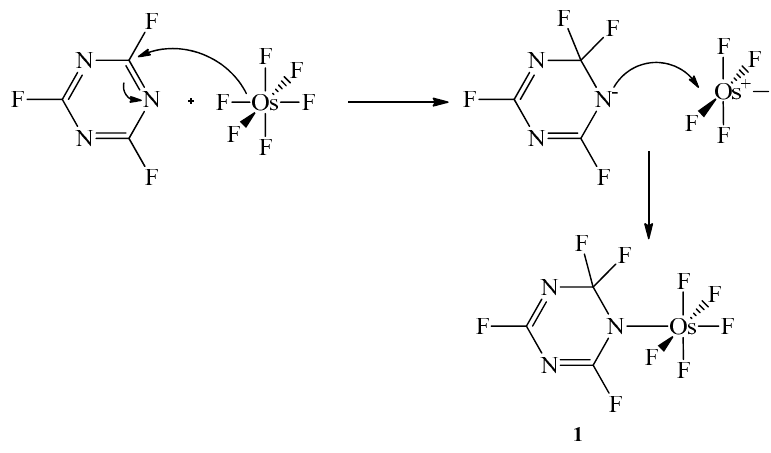
Scheme 1. Proposed stepwise formation of 1 .